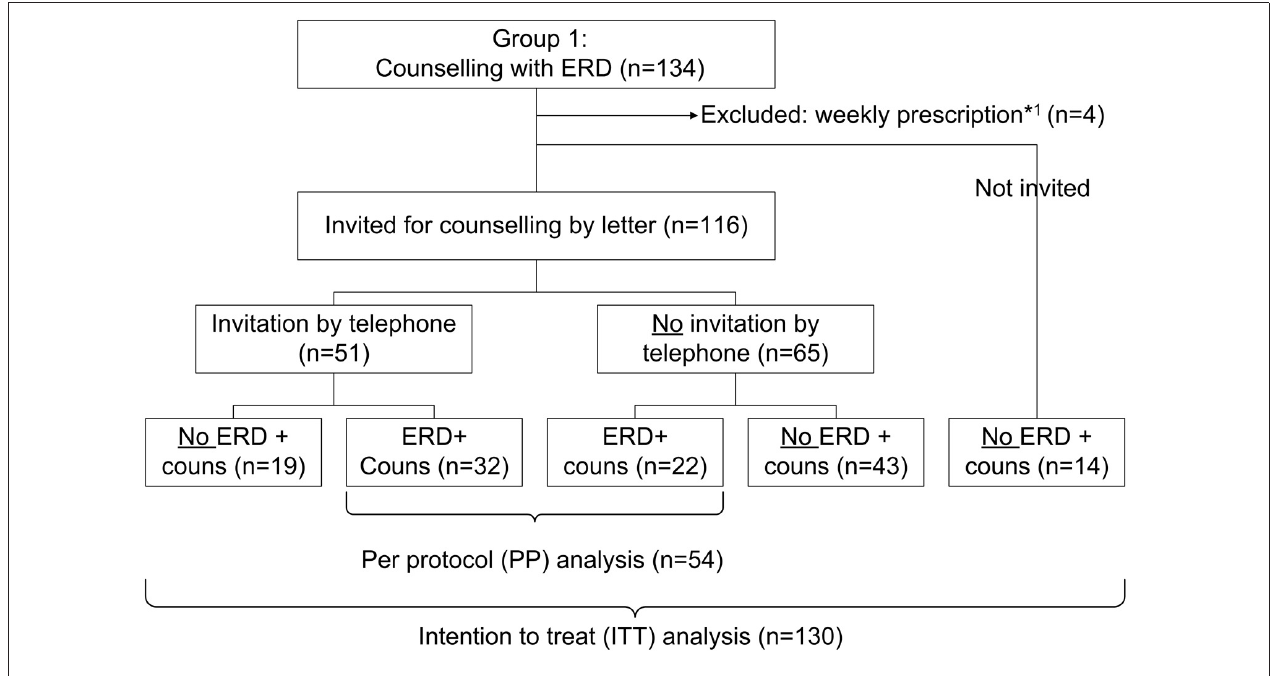
FIGURE 3 | Information about inclusion of patients in ERD/counseling group.